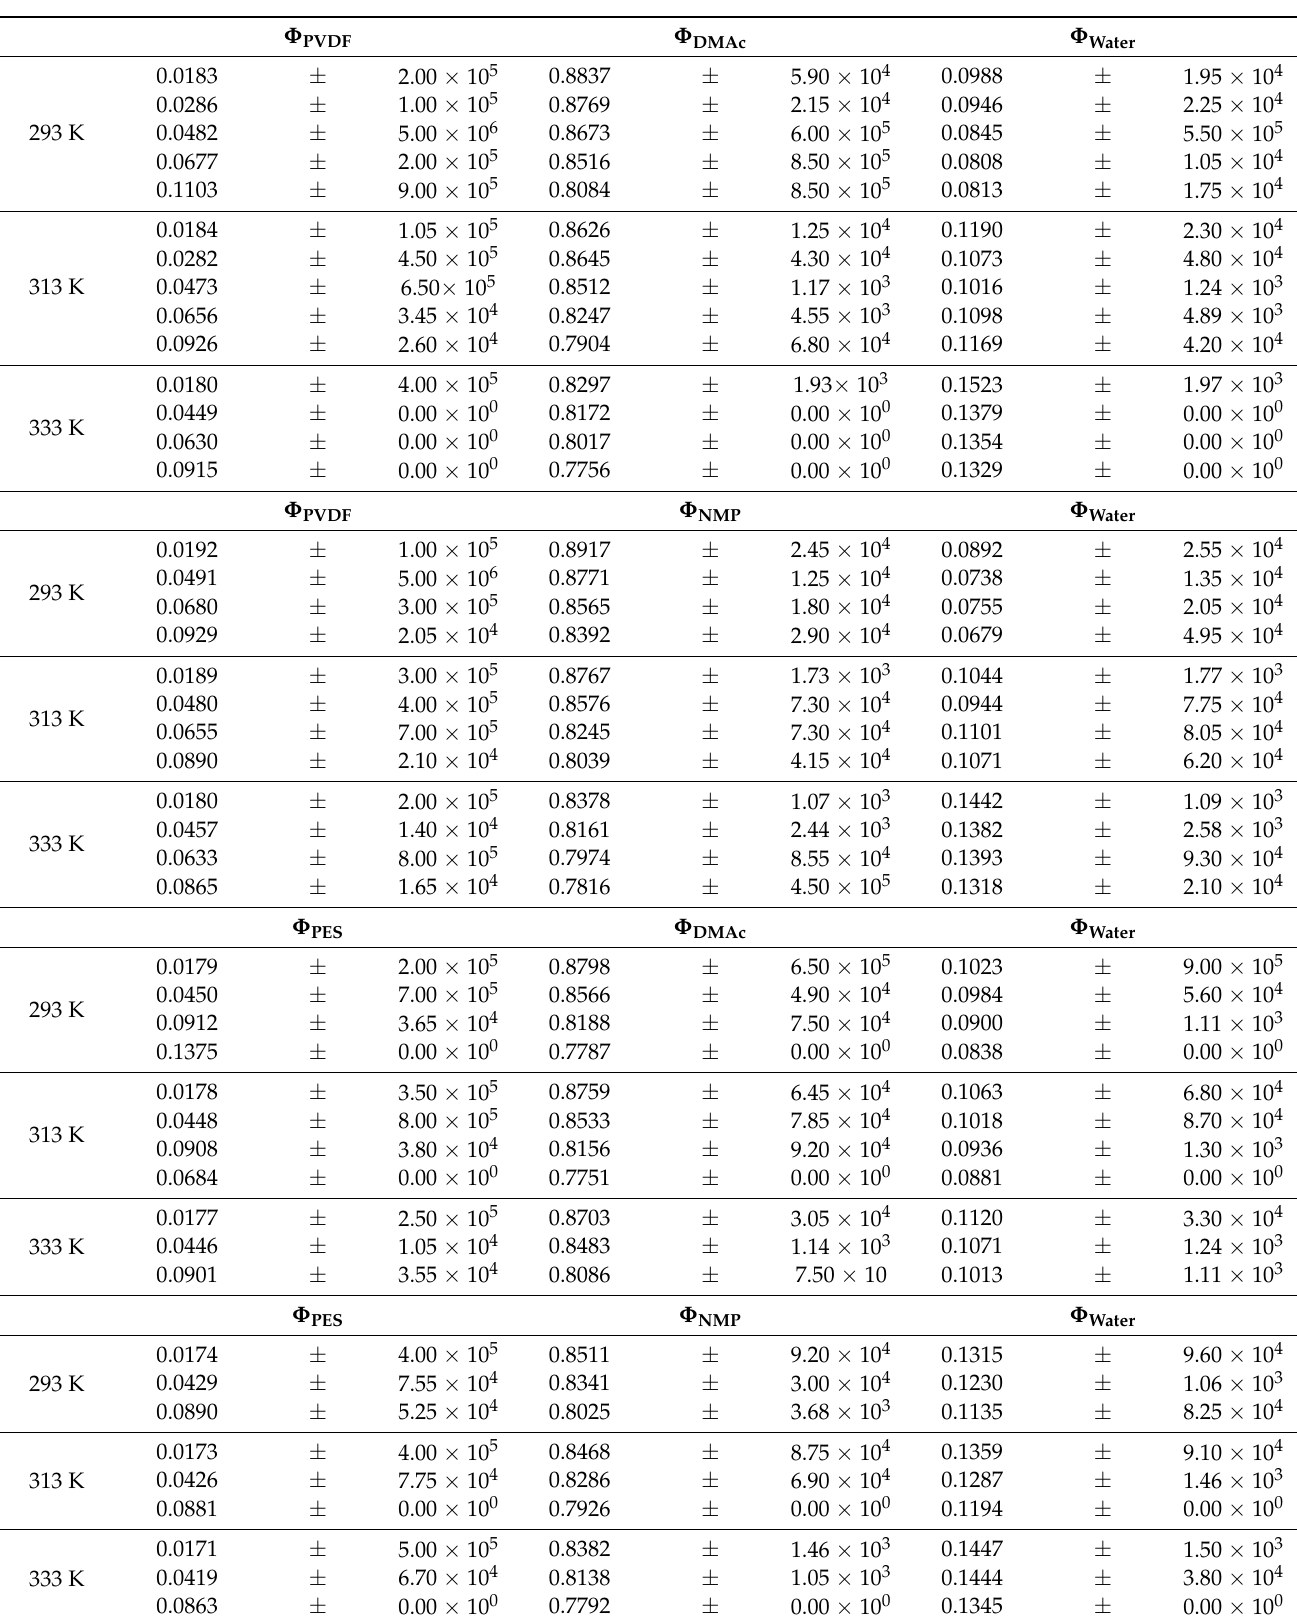
Table A3. Average values of cloud point data at the three temperatures for the four studied